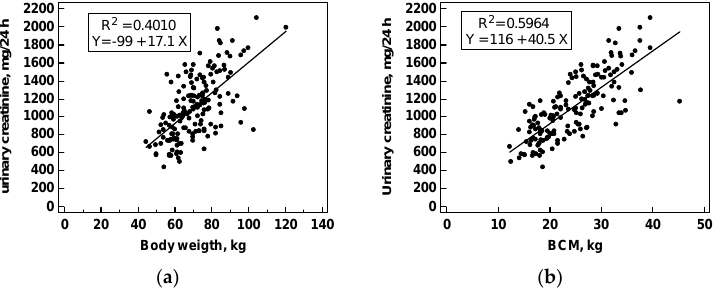
Figure 2. Correlations of 24 ‐ h urinary creatinine excretion (mg/24 h) with ( a ) body weight and ( b ) body cell mass (BCM). Parameters of linear regression and correlation coefficients R 2 are reported.